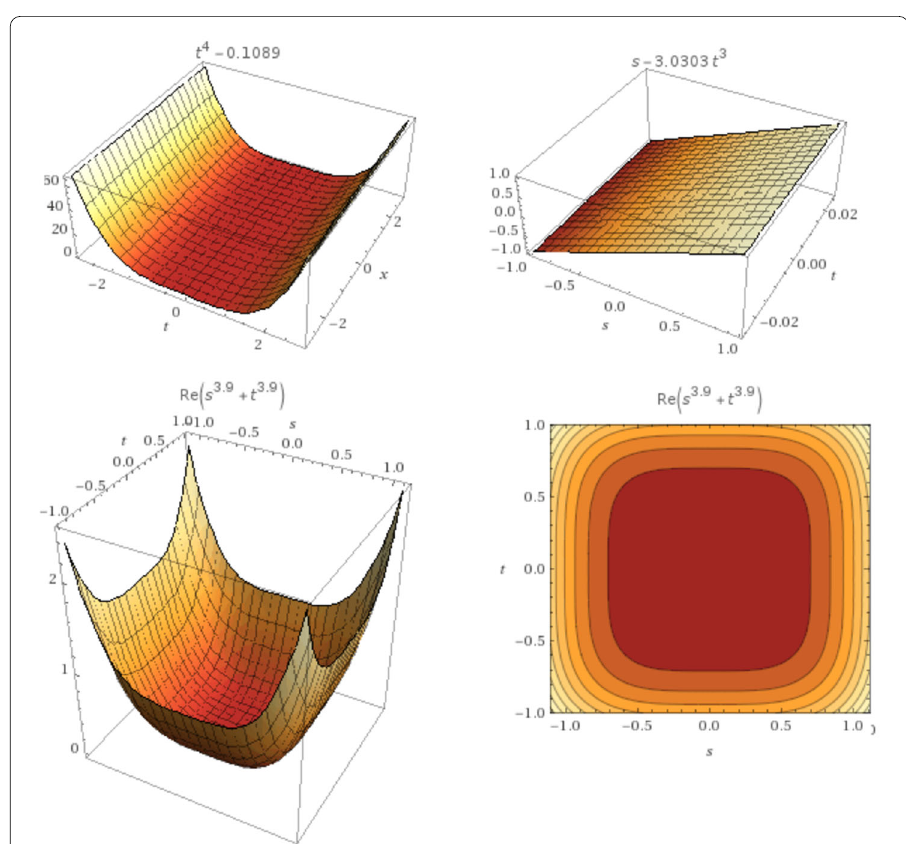
Figure 5 From the left: the graph represents τ 4 – 0.1089 and ς – 3.03 τ 3 respectively. The second row represents the fractional case with μ =